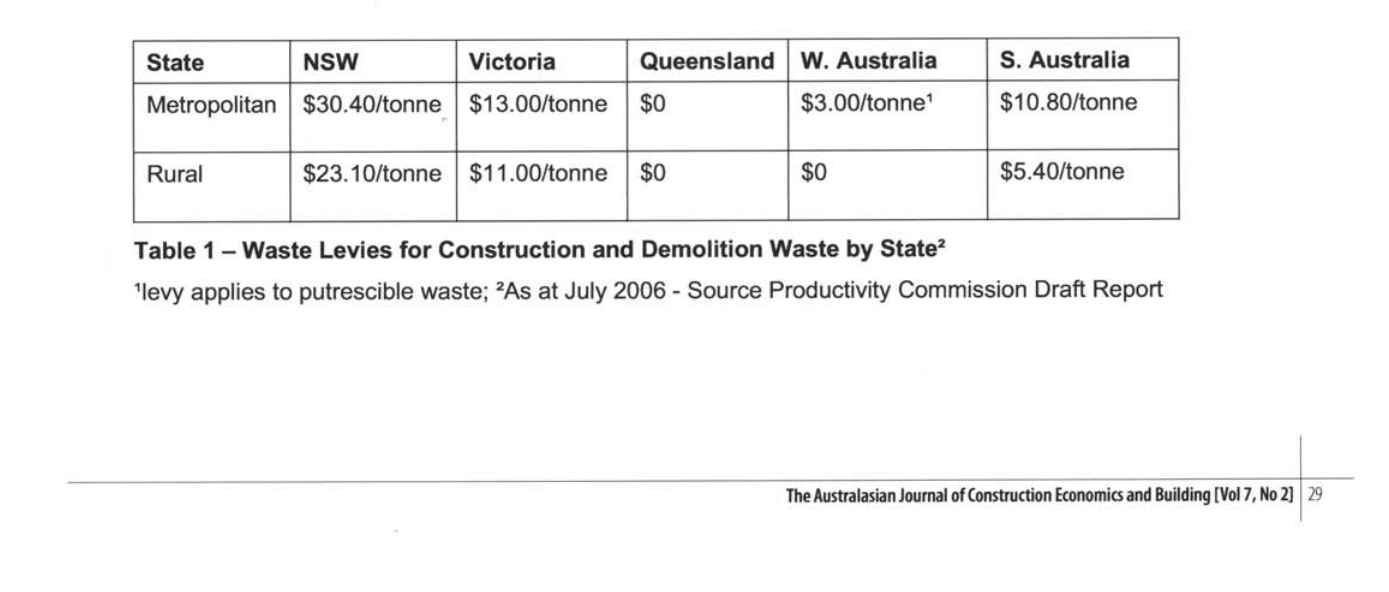
Table 1 - Waste Levies for Construction and Demolition Waste by State